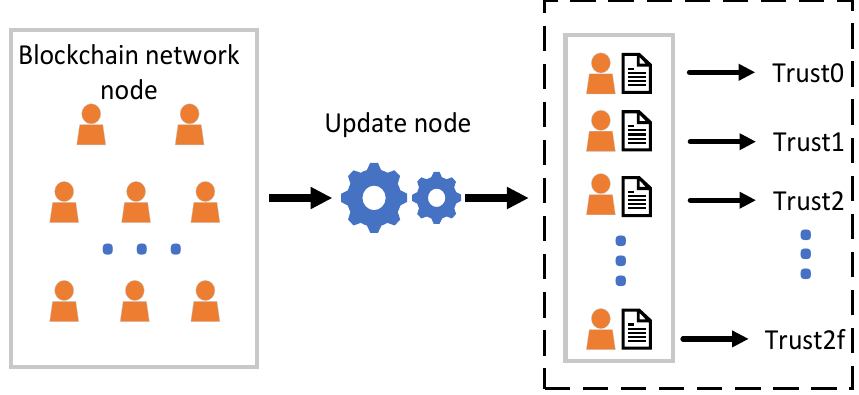
Figure 2. Node classification and